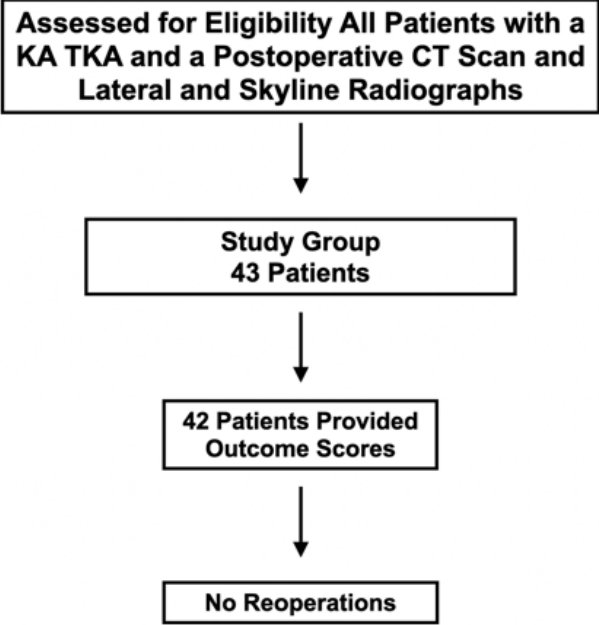
Figure 2. The flowchart shows the number of patients assessed for eligibility included in the study group that provided outcome scores and treated with reoperation.